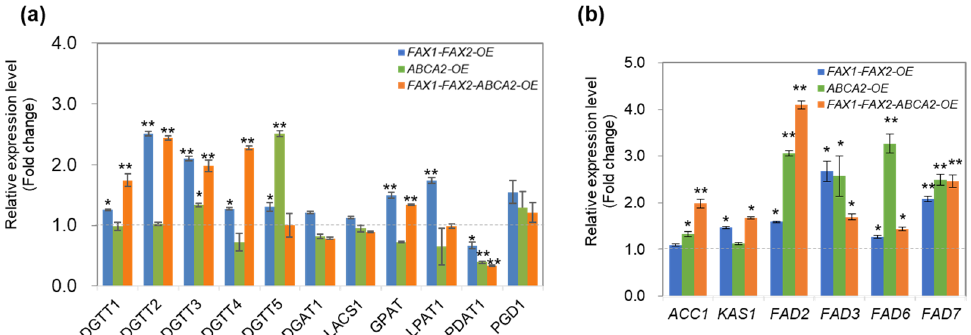
Figure 3. The transcriptional levels of key genes involved in TAG ( a ), and FA biosynthesis ( b ) under TAP-N for 48 h analyzed by RT-qPCR. ACC1, acetyl-CoA carboxylase; KAS1, 3-ketoacyl-CoA-synthase; DGAT, diacylglycerol acyltransferases; DGTT, type II diacylglycerol acyltransferases; FAD, fatty acids desaturases; GPAT, Glycerol-3-phosphate acyltransferase; LPAT1, lysophosphatidic acid acyltransferase 1; LACS1, long-chain acyl-CoA synthetase 1; PGD1, plastid galactoglycerolipid degradation 1; PDAT1, phospholipid:diacylglycerolacyltransferase 1; PUFA, polyunsaturated fatty acids. The RT-qPCR results were normalized using the housekeeping gene RACK1 as the internal standard, and the fold changes of the relative expression levels were determined relative to the parental line (PL). Error bars represent standard errors based on four biological replicates. Statistical